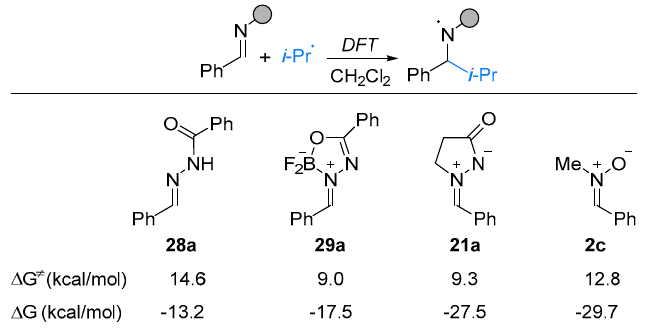
Scheme 27. DFT calculations for the addition of iso -propyl radical to various C-N double bond derivatives including